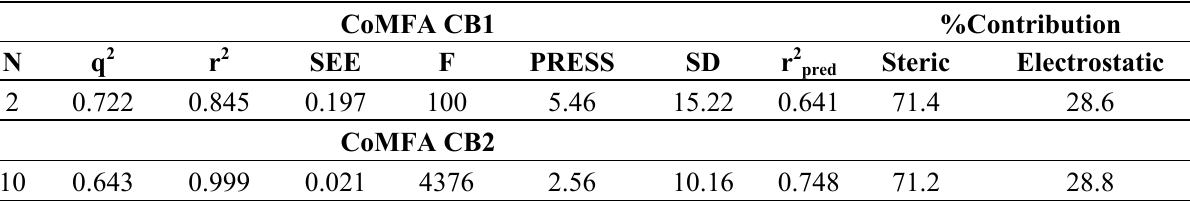
Table 1. Statistical parameters of the CoMFA models a .